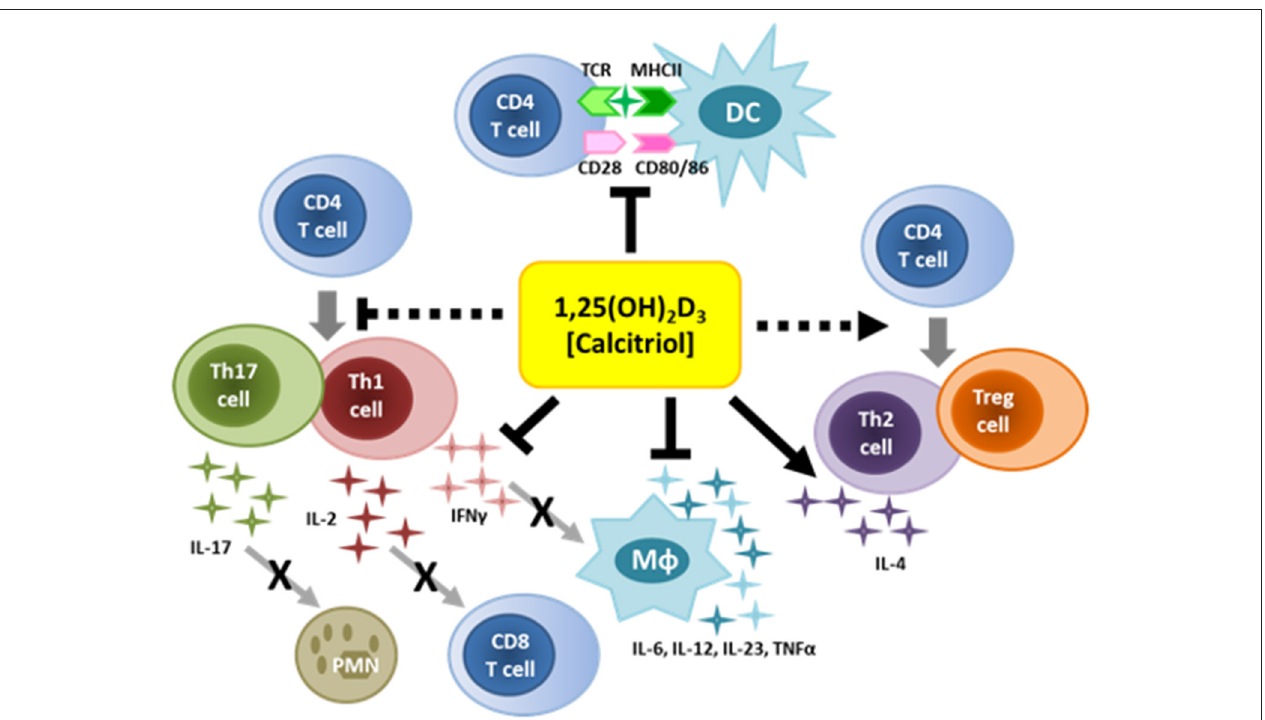
FIGURE 3 | Immunoregulatory functions of vitamin D. VitD can regulate the function of numerous immune cells. VitD suppresses inflammatory cytokines and antigen-presentation by innate immune cells. VitD also suppresses T cell activation, and favors the generation of Th2 cells and